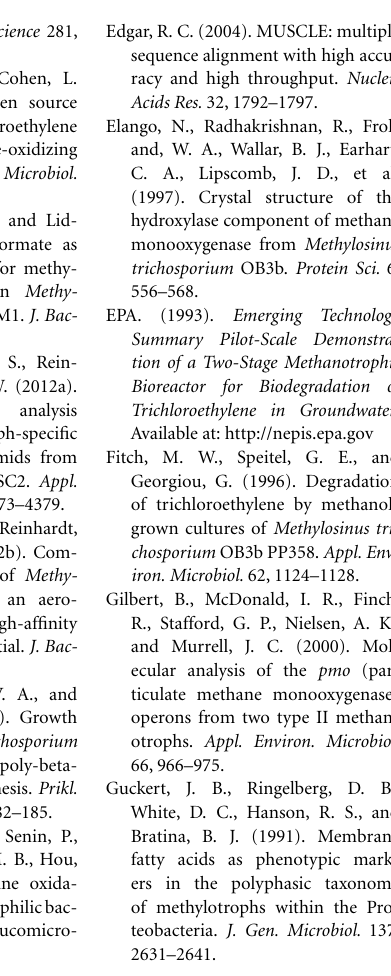
Bases from the + strand are shown across the top of the figure. (D) The − 270 to − 210 region upstream of mclA . Figure S5 | RNA-Seq reads mapped per base relative to start of fae1-1 . Left, the average number of reads mapped to the region − 235 to − 185 upstream from the start of fae1-1 gene for two biological replicates.The sequence at each base is shown above the bars. Right, the range (shown in red) and mean of two biological replicates (shown as black line) for the number of reads mapped per base for the coding and downstream region of the fae1-1 and fae1-2 genes. Figure S6 | Primary structure alignment for phosphoenolpyruvate carboxylases (Ppc1 and Ppc2) from M. trichosporium OB3b and Ppc-homologs. Table S1 |Transcripts detected by de novo assembly RNA-Seq data. Table S2 | Gene expression profile in methane-grown cells of M. trichosporium OB3b. Values represent reads per kilobase of coding sequence per million (reads) mapped (RPKM). Table S3 | Summary of putative transcription site mapping (Note that the published sequences need references added). Table S4 | Summary of RNA-seq (Illumina) reads. Table S5 | Genes removed from reference scaffold before